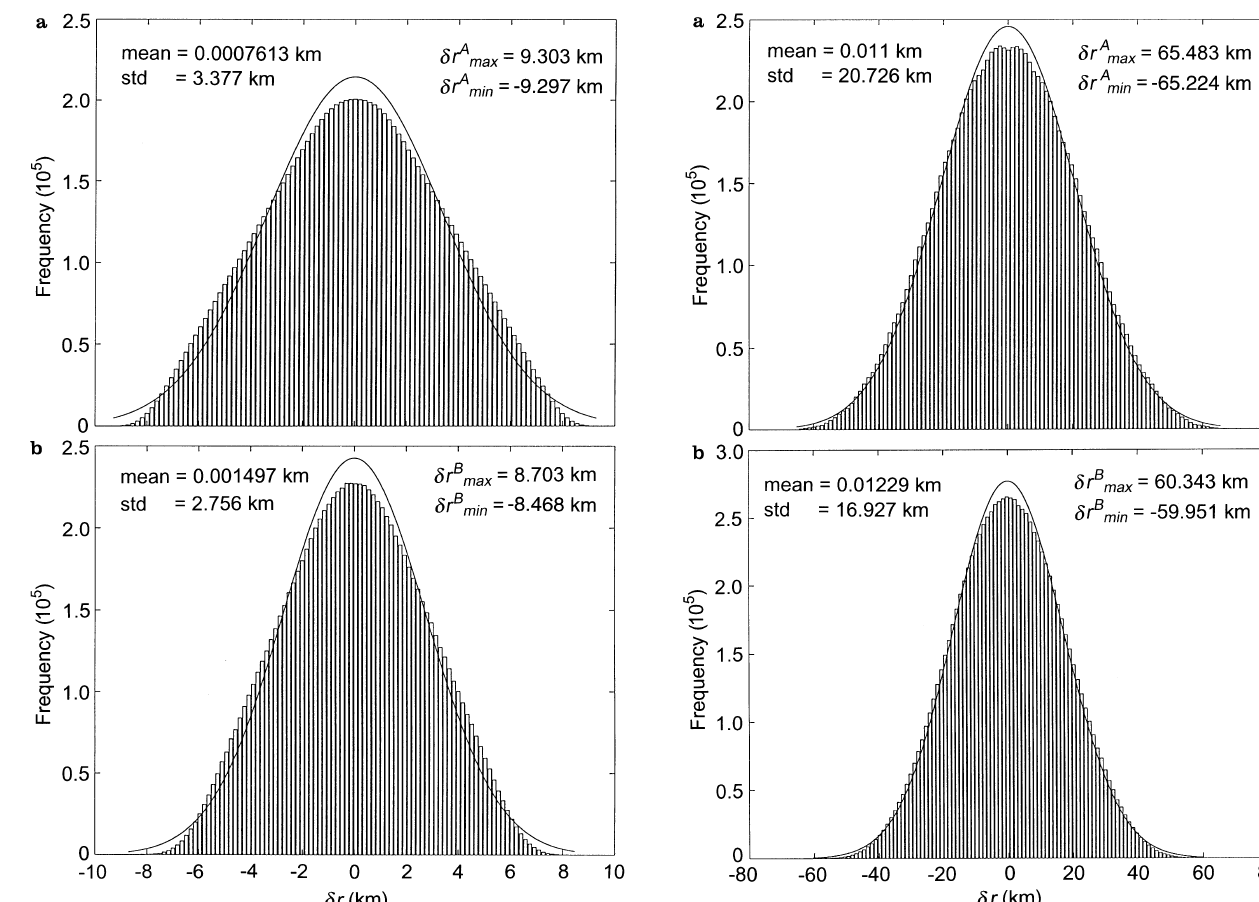
Table 4. Since (cid:100) r max and (cid:100) r min are always associated with